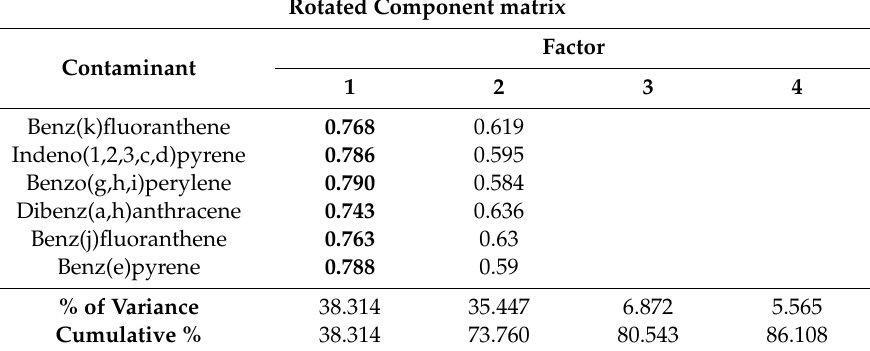
Table 2. Cont . Rotated Component matrix